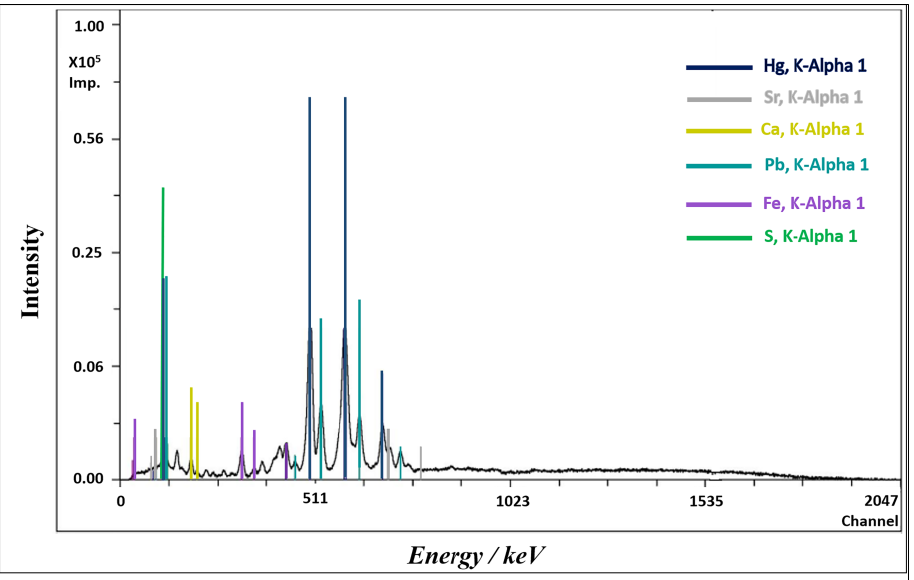
Figure 8. X-ray fluorescence spectrum of the wooden sculptural group.